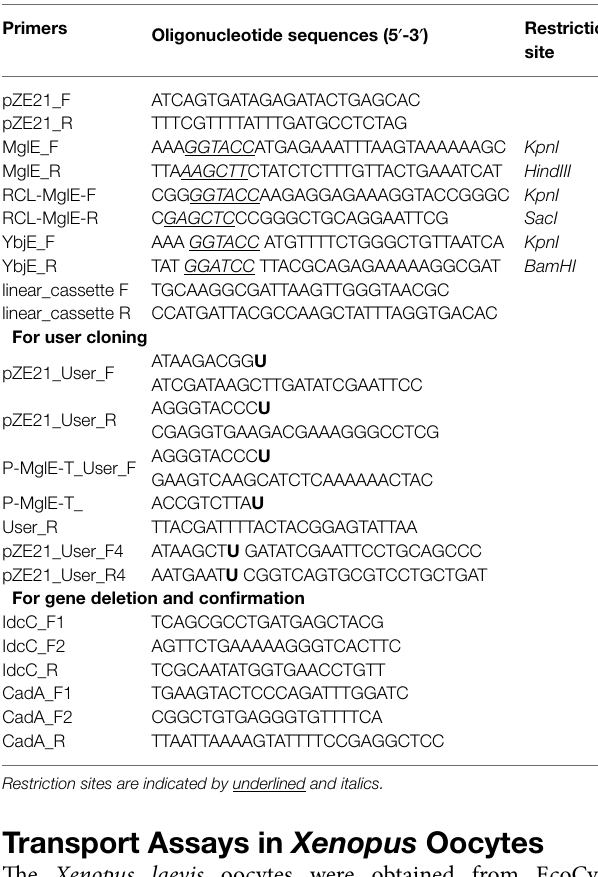
TABLE 2 | Oligonucleotides used in this study. Primers Oligonucleotide sequences (5